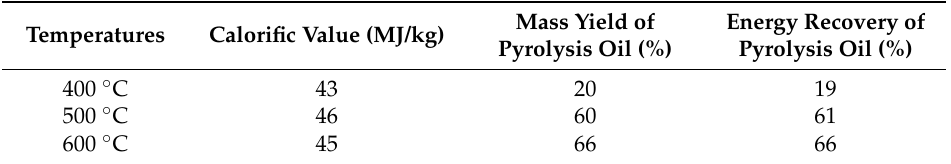
Table 3. Calorific value, mass yield and energy recovery of pyrolysis oil at different pyrolysis temperatures. Temperatures Calorific Value (MJ/kg)